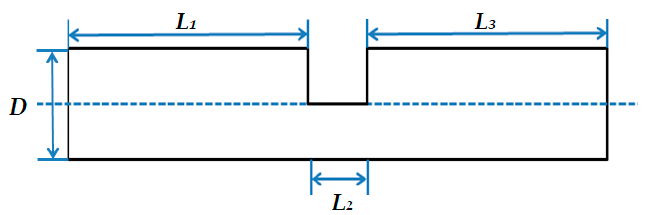
Figure 18. The model diagram of the valve.